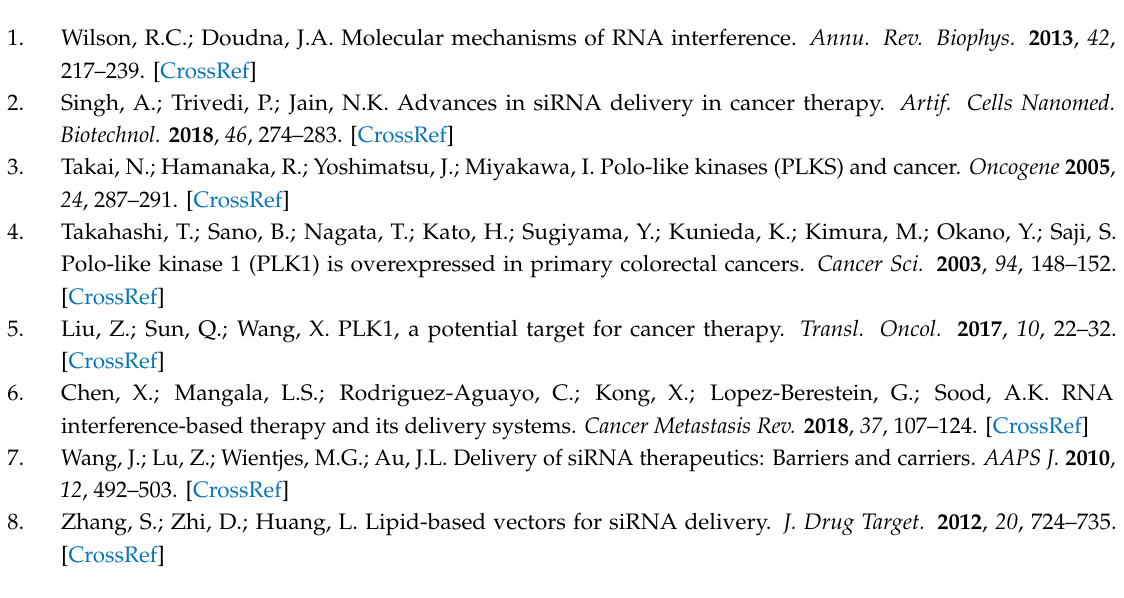
Figure S1. E ff ect of charge ratio ( + : − ) of siRNA lipoplexes on gene suppression in KB-Luc cells after transfection with siRNA